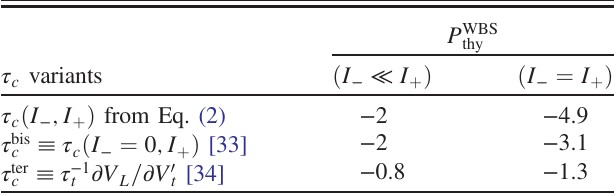
TABLE II. Predicted P WBS at ν ¼ 1 = 3 for alternative defini- thy tions of τ and different source settings (symmetric when I − ¼ 0 c ≡ I I or fully asymmetric when I − ¼ (cid:3) I , with I ). τ is the t (cid:3) b c þ (cid:3) transmission ratio of incident quasiparticles, τ bis the same trans- c mission ratio but at I − ¼ 0 , and τ ter the transmission ratio of c thermal excitations. The corresponding values of P WBS are thy obtained, respectively, from Eq. (8) and Eqs. (F1) and (F2) in Appendix